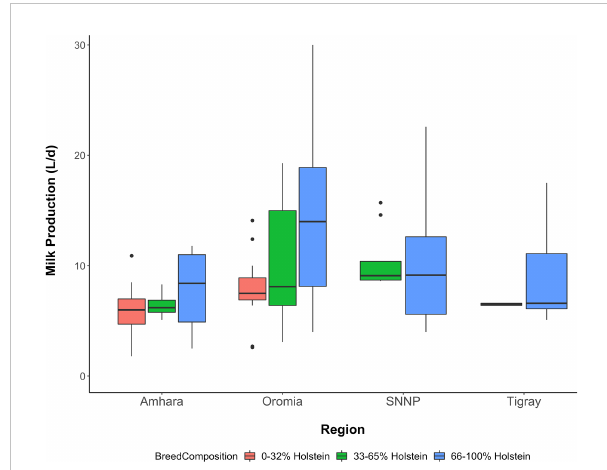
FIGURE 6 Milk production (L/d) per region per breed composition (Holstein-Friesians).